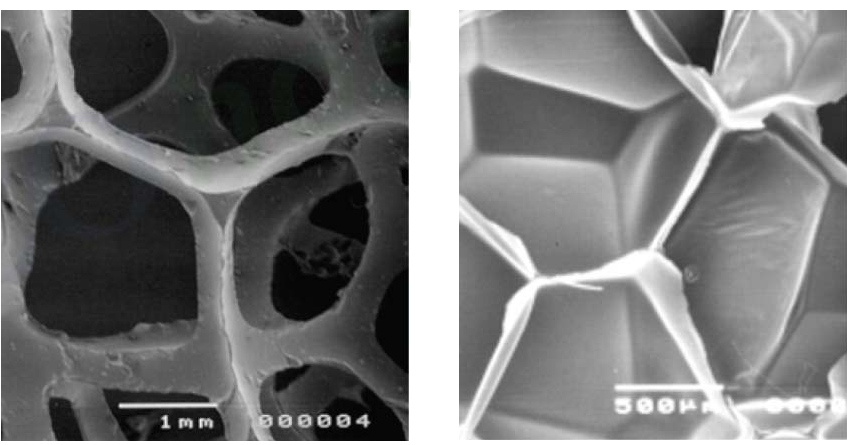
Рис . 3 – Открытые ячейки ( а ) закрытые ячейки ( б ) экспандированного